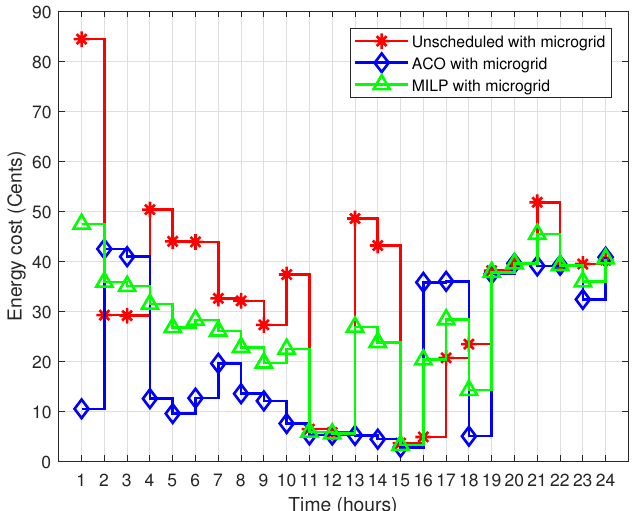
Figure 18. Per hour energy cost minimization evaluation considering microgrid.